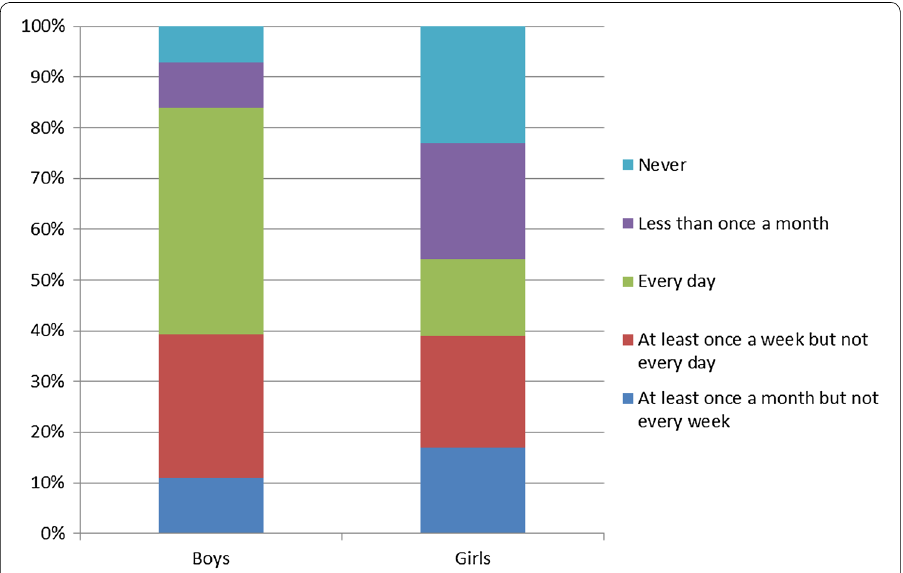
Fig. 9 Using a computer for playing games (outside of school) by gender (estimated percentages across all participating